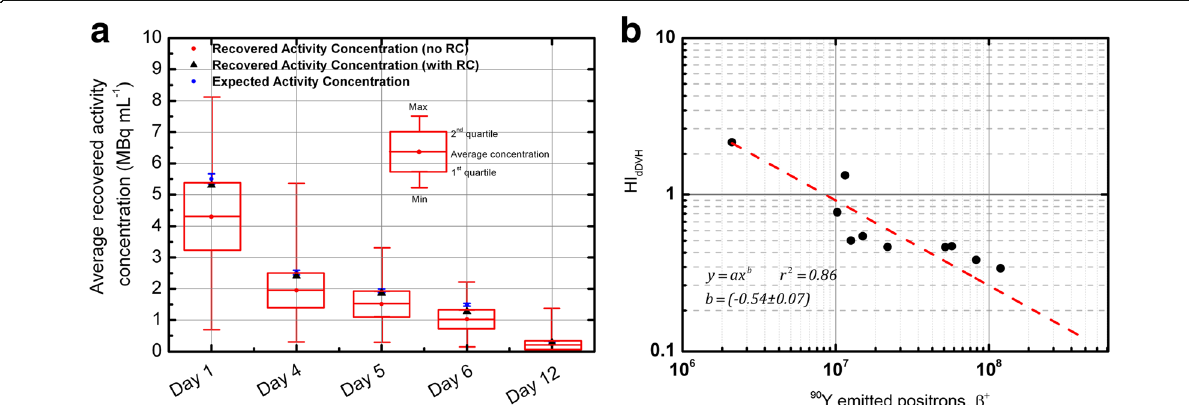
Fig. 4 Quantitative analysis. a Recovered activity concentration in the tumor insert of the anthropomorphic phantom. Data are presented in terms of minimum and maximum recovered activity values, 1st and 3rd quartile, average activity concentration and recovered activity concentration after correcting for PVE. After the application of RCs, differences with measured activity concentration values reduce significantly with underestimations of the order of 4% down to an activity concentration of about 2 MBq mL − 1 . b For each phantom acquisition HI dDVH were plotted as a function of the number of positrons emitted from the VOI. A power function of the form y = ax b was used to fit data points, where x is the number of emitted positrons from the VOI and a and b coefficients to be determined from the fit. From the regression analysis it resulted b = − 0.54 ± 0.07 (with r 2 = 0.86)